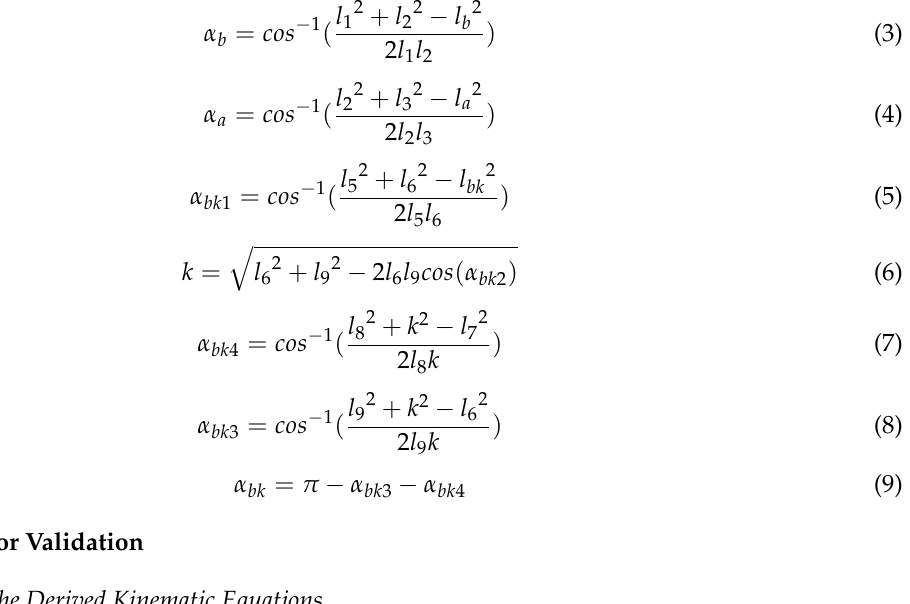
Figure 3. A simple schematic of the boom, stick, and bucket cylinder illustrating the specific angle and cylinder